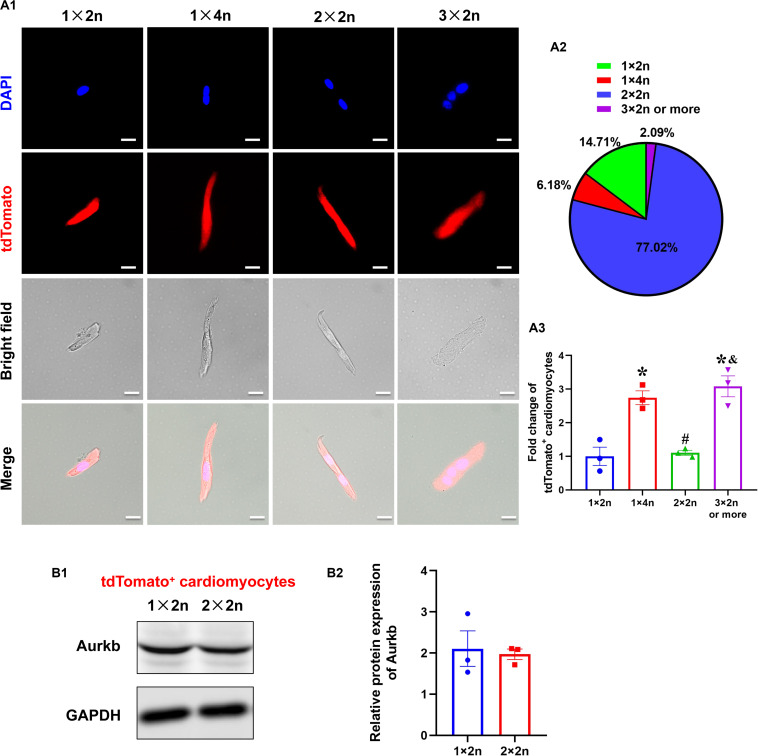
The analysis of tdTomato+ cardiomyocytes with different ploidy. (A,A1) Immunostaining for tdTomato with DAPI on P7 isolated rod-shaped cells of Tnnt2-Dre × Aurkb-rox-tdTomato ventricles. Scale bar = 20 μm. (A2) Quantification of nucleation and ploidy proportion on P7 isolated rod-shaped cells of Tnnt2-Dre × Aurkb-rox-tdTomato ventricles. (A3) Relative fold change of tdTomato+ proportion on P7 isolated rod-shaped cells of Tnnt2-Dre × Aurkb-rox-tdTomato hearts in each nucleation/ploidy proportion. n = 3, *p < 0.05 vs. 1 × 2n; #p < 0.05 vs. 1 × 4n; &p < 0.05 vs. 2 × 2n. (B) Representative images (B1) and quantification (B2) of Aurkb protein expression in sorting diploid (1 × 2n) and tetraploid (2 × 2n) tdTomato+ cardiomyocytes from P7 Tnnt2-Dre × Aurkb-rox-tdTomato ventricles, analyzed by Western blotting. GAPDH was used as control. n = 3.